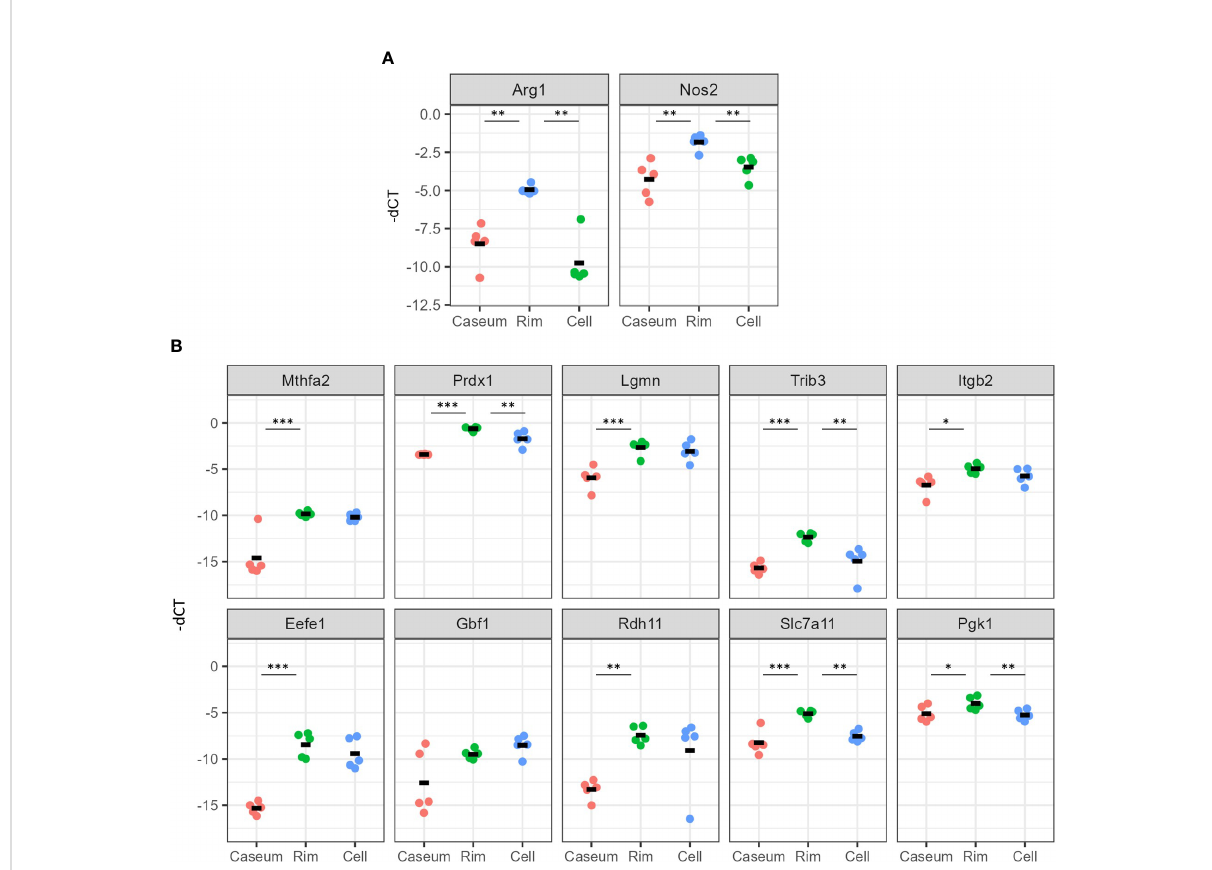
FIGURE 8 Veri fi cation of gene expression related to activation of M2 macrophages and mTORC1 signaling in necrotic granulomatous regions. RNA extracted from necrotic granulomatous regions (n = 5) was subjected to quantitative reverse-transcription PCR. Genes related to the macrophage activation markers, Arg1 and Nos2 (A) and mTORC1 signaling (B) , which are listed as the top 10 genes for the core enrichment in Figure 6D, were examined. The Ct values for the indicated genes normalized to that of Actb (-dCt) are indicated. * P < 0.05, ** P < 0.01, *** P < 0.005 (Dunnett multiple comparison test following